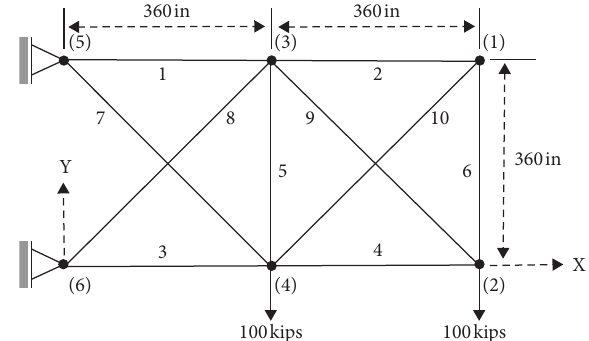
Figure 5: Effects of various values of CR on average weight of designs for the 10-bar truss using DE with F � 0.5.